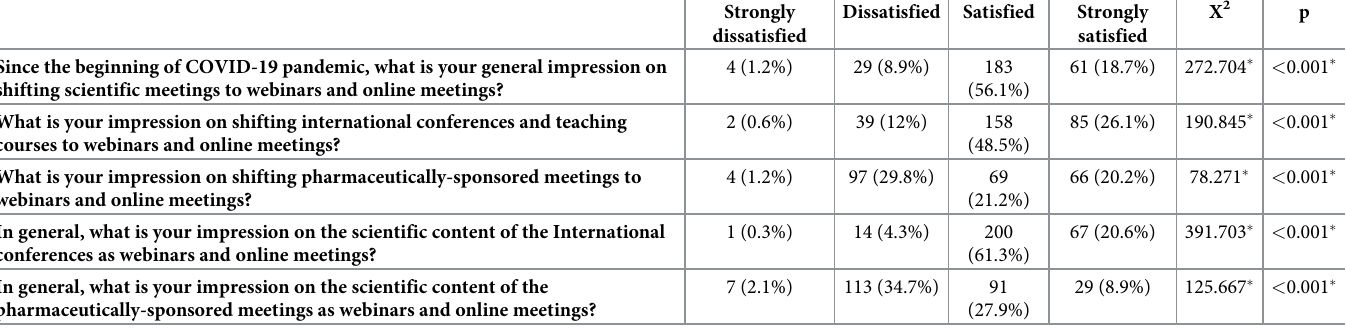
Table 3. Distribution of survey responses according to satisfaction with different webinars and online meetings (n = 326).